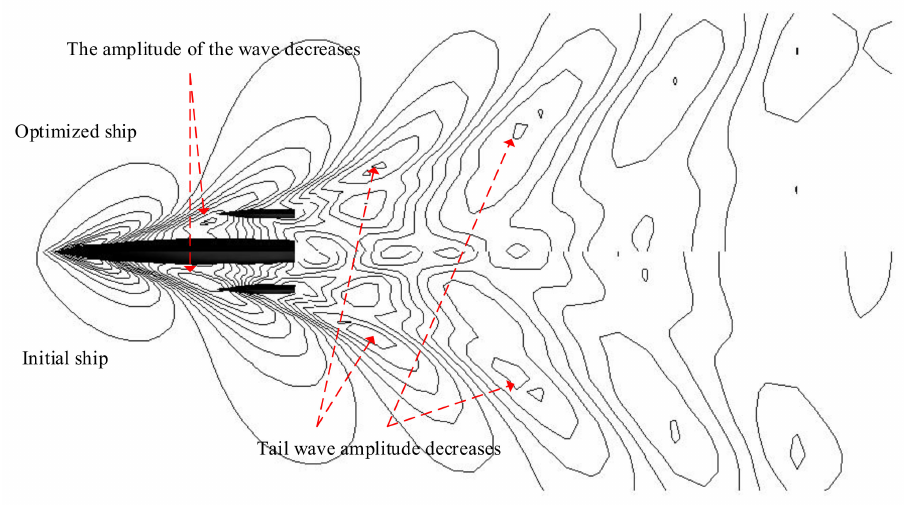
Figure 15. Wave forms.